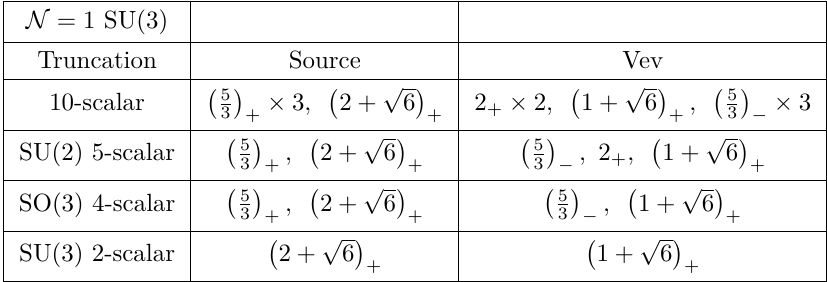
Table 1 . BPS modes and multiplicities for the N = 1 SU(3) invariant